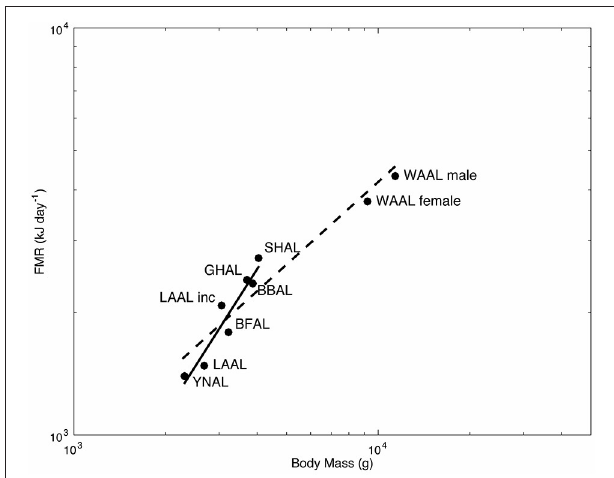
FIGURE 3 | Allometry of field metabolic rate (FMR; kJ d − 1 ) for albatrosses measured using the doubly labeled water method. FMR and body mass (g) are plotted on a logarithmic scale for WAAL male and female (wandering albatross Diomedea exulans ; Shaffer et al., 2001a), SHAL (shy albatross Thalassarche cauta ; Green and Brothers 1995, Abstract from First International Albatross and Petrel Conference, Hobart, Australia), GHAL (gray-headed albatross T. chrysostoma ; Costa and Prince, 1987), BBAL (black-browed albatross T. melanophrys ; Shaffer et al., 2004), LAAL Inc. (Laysan albatross Phoebastria immutabilis during incubation; Pettit et al., 1988), and BFAL (black-footed albatross P. nigripes ), LAAL (Laysan albatross), and YNAL (Indian